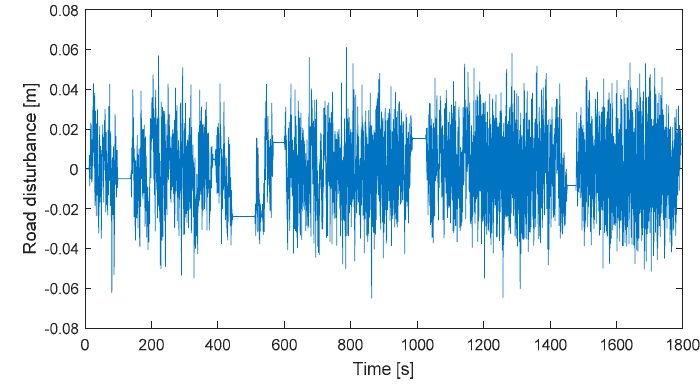
Figure 8. The C level road input coupled with WLTC.